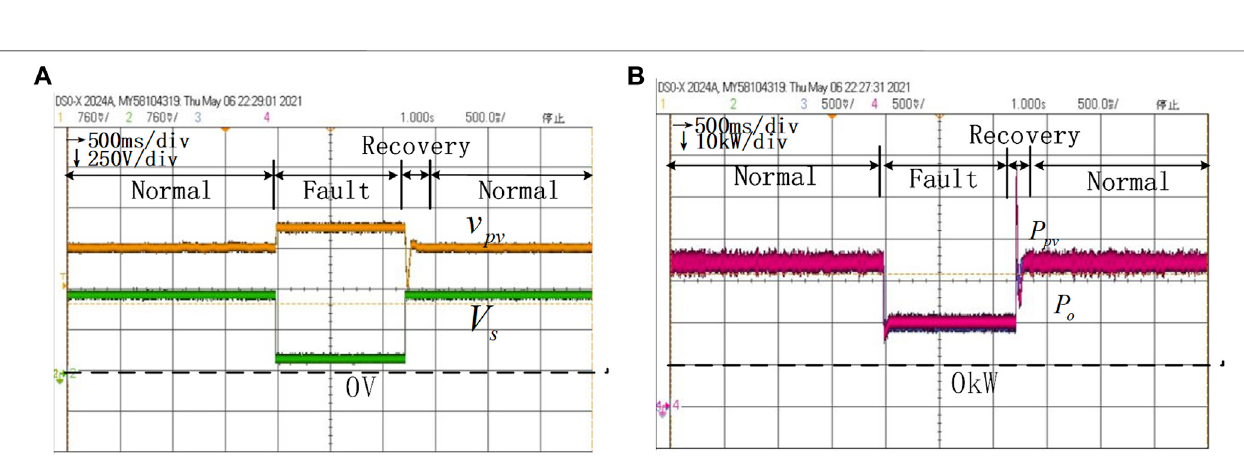
FIGURE 14 | HIL results of voltage dynamics and power dynamics with the variable parameter control under the conditions k p (cid:1) 0 . 1 , k i (cid:1) 5 , and C pv (cid:1) 1mF. (A) Voltage dynamics of v s and v pv . (B) Power dynamics of P o and P pv